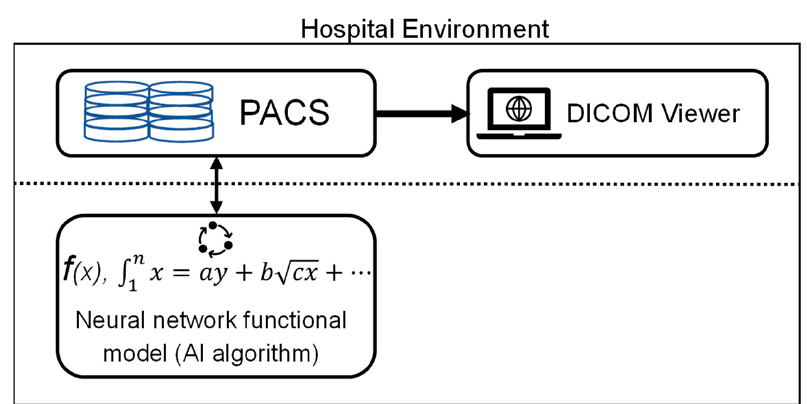
Figure 2. AI algorithm embedded in the PACS infrastructure of the hospital. AI: artificial intelli- gence; DICOM, digital imaging and communications in medicine; PACS, picture archiving and communication system.